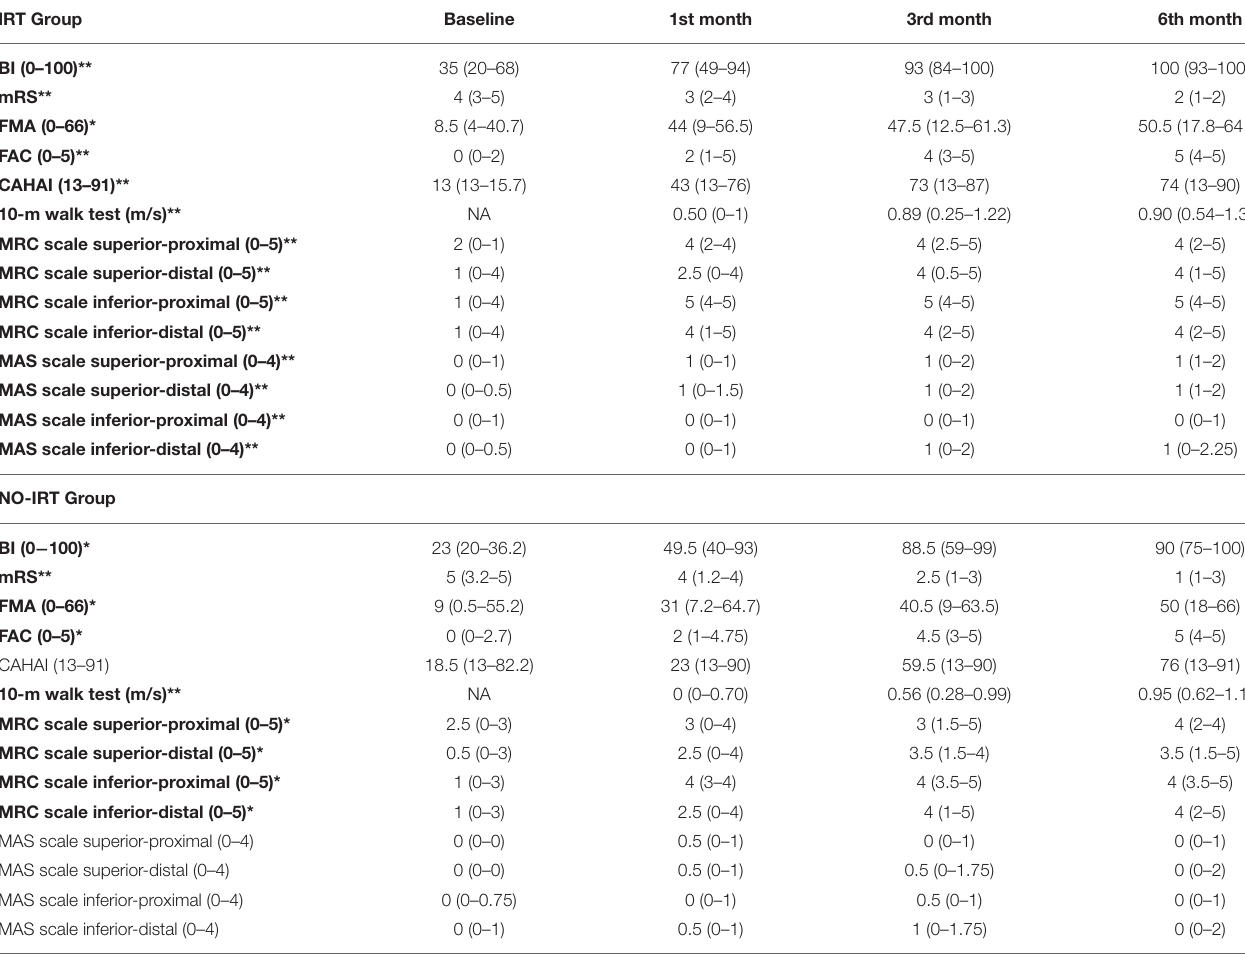
TABLE 5 | Measures of functional and motor